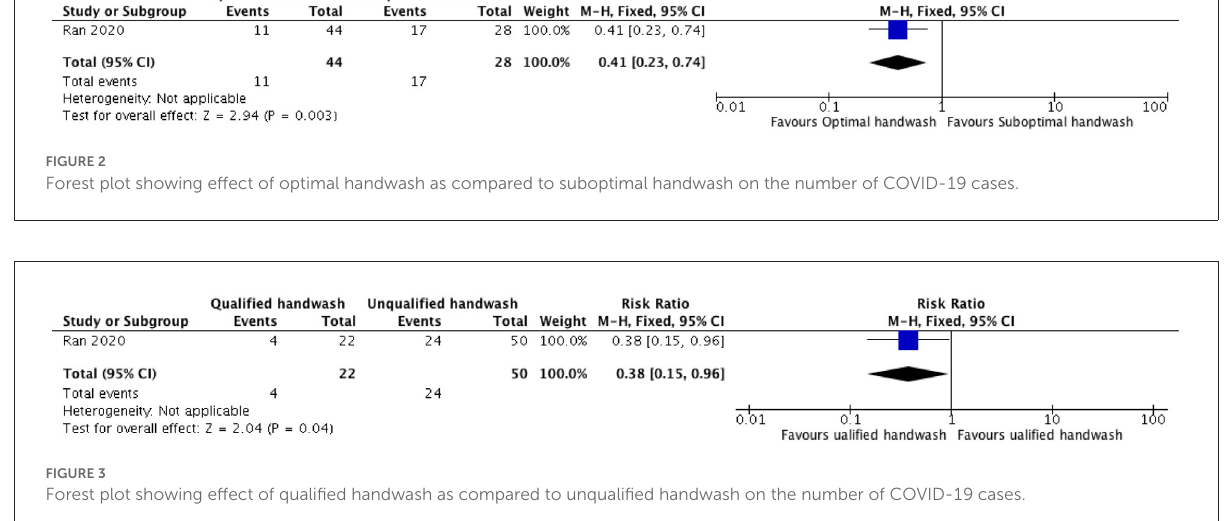
dispensers at the checkpoint for glove-on hand rubbing between zones of risk was effective [OR (95%CI) 0.043 (0.003–0.627); P = 0.021]